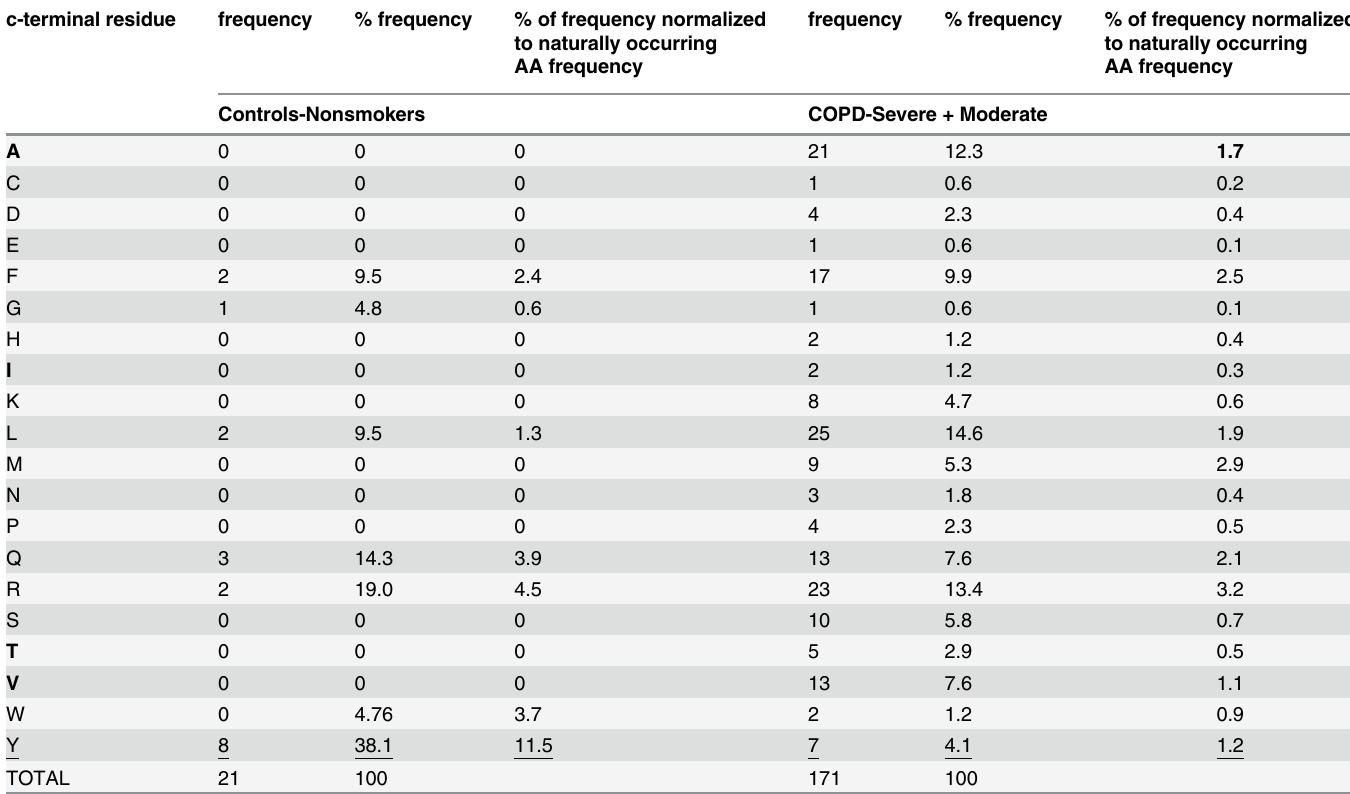
Table 2. C-Terminal Peptide